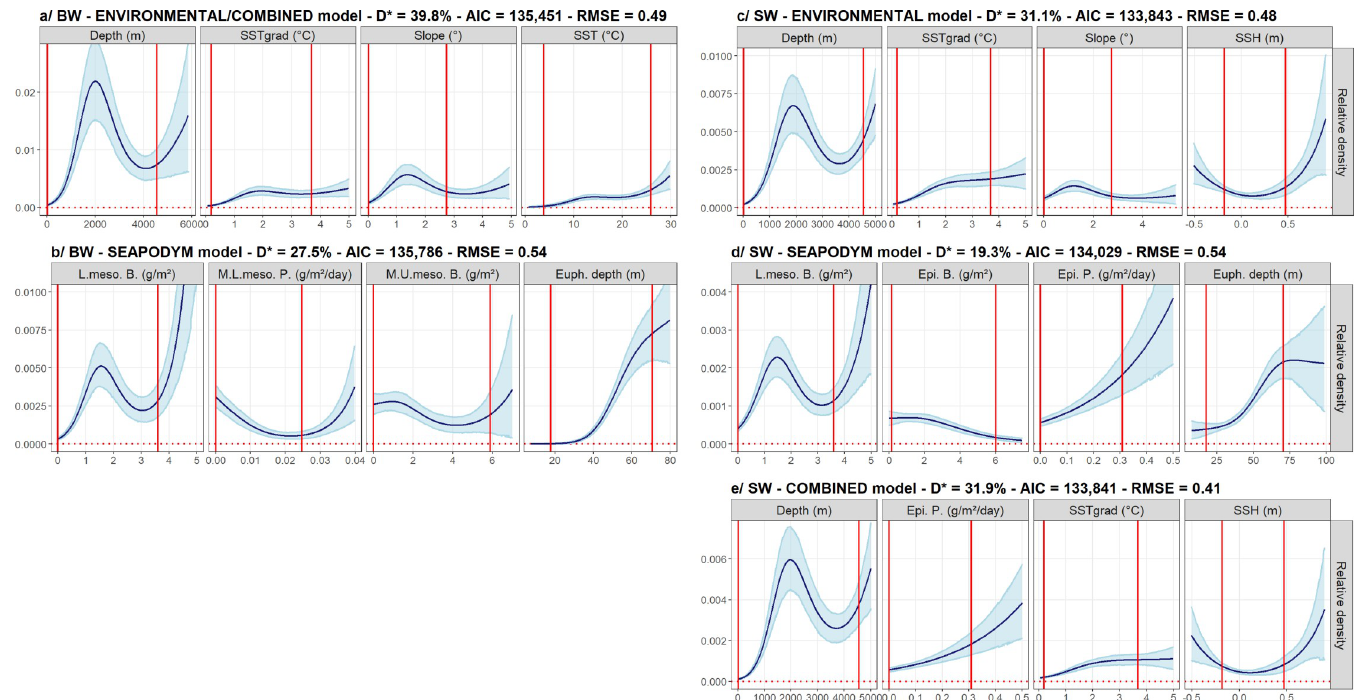
Fig 3. The functional relationships between beaked (BW) and sperm (SW) whales and the selected variables of the ENVIRONMENTAL (a, c), SEAPODYM (b, d) and COMBINED (a, e) models. The ENVIRONMENTAL and COMBINED models were identical for beaked whales thus represented only once. Solid lines represent the estimated smooth functions and the blue shaded regions show the approximate 95% confidence intervals. The relative density of individuals (individuals per 750 km 2 ) is shown on the y-axis, where a zero indicates no effect of the covariate. Red vertical lines indicate the 2.5 th and 97.5 th percentile intervals corresponding to the core data. D � : explained deviance; AIC: Akaike criterion; RMSE: Root Mean Squared Error; SSTgrad: gradients of Sea Surface Temperature; L.meso. B.: lower mesopelagic biomass; M.L.meso.P.: migrant lower mesopelagic production; M.U.meso.B.: migrant upper mesopelagic biomass; Euph. depth: euphotic depth; SSH: sea surface height; Epi. B.: epipelagic biomass; Epi. P.: epipelagic production.